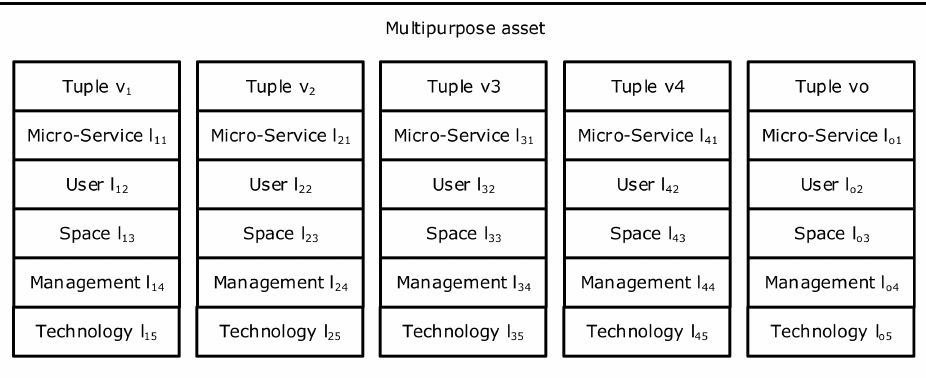
Figure 3. Asset Ommi-management model.